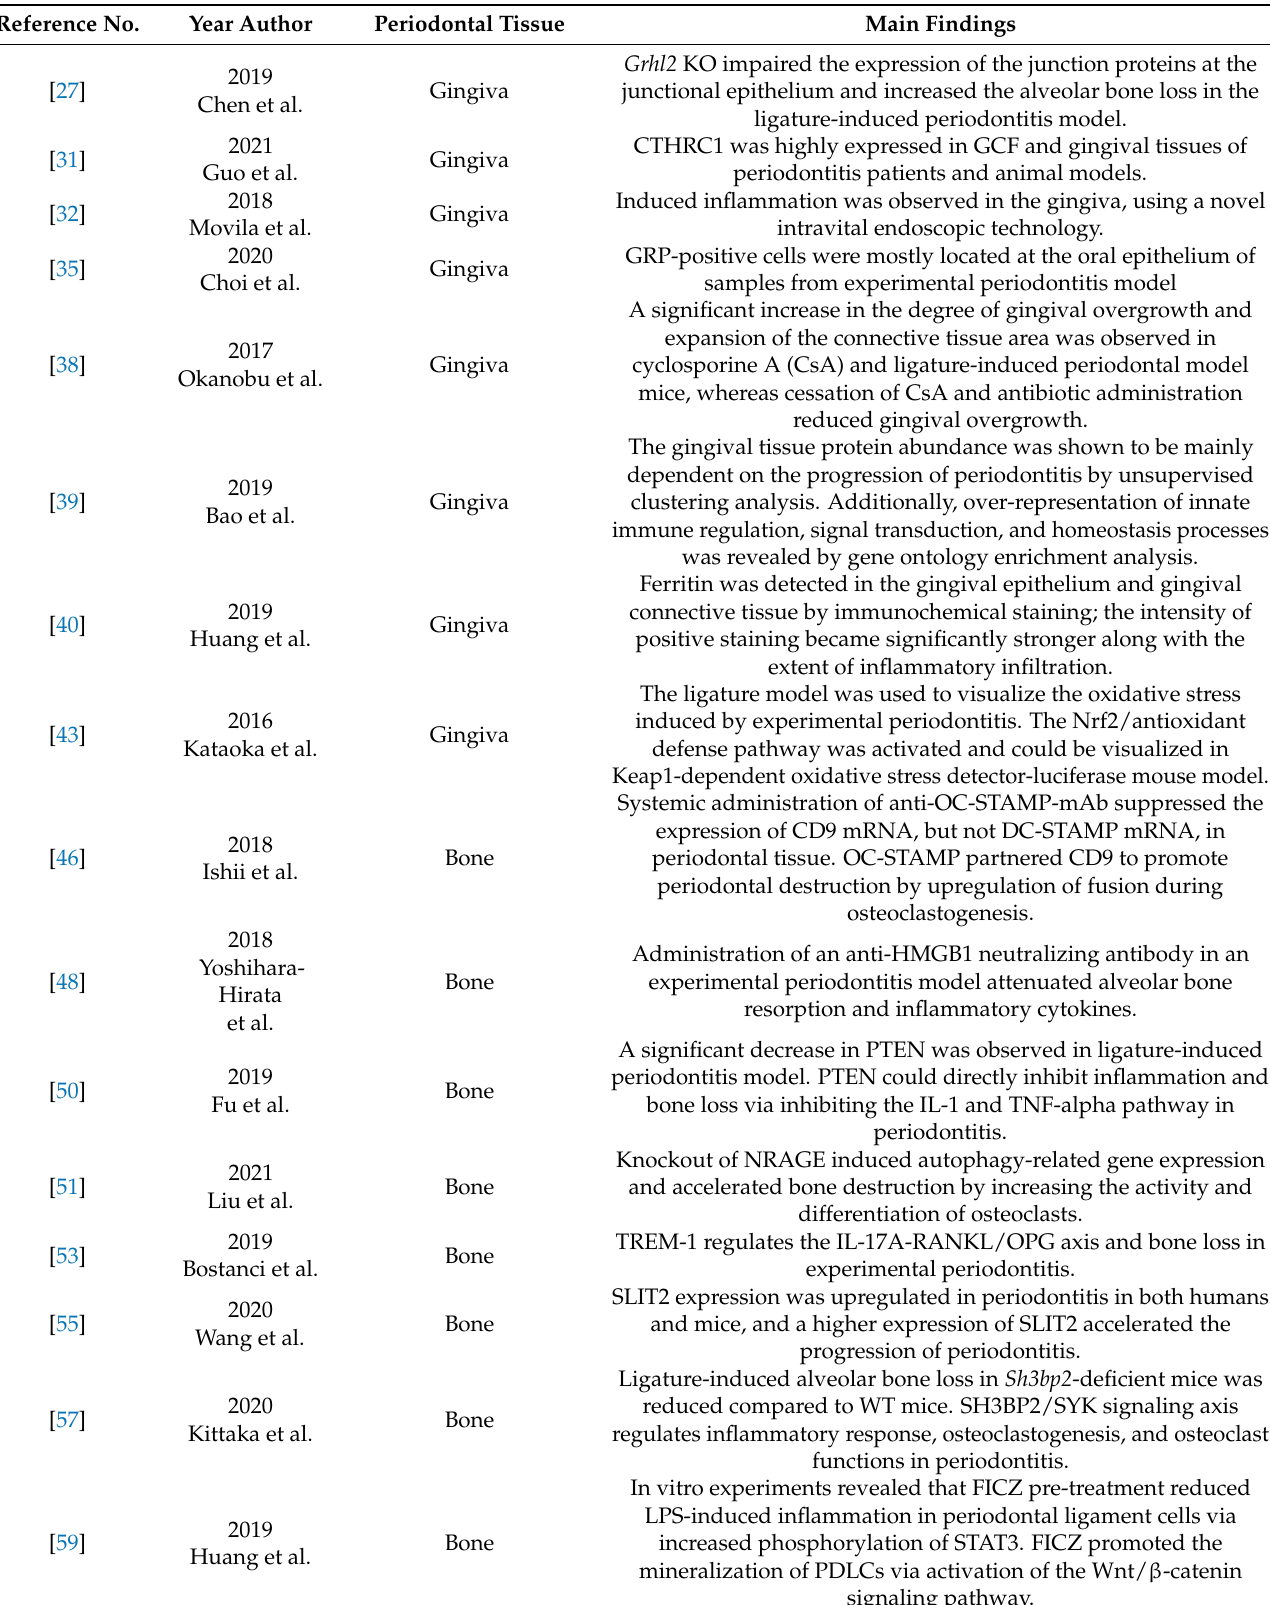
Table 1. Summary of periodontal tissue of ligature-induced periodontitis model. Reference